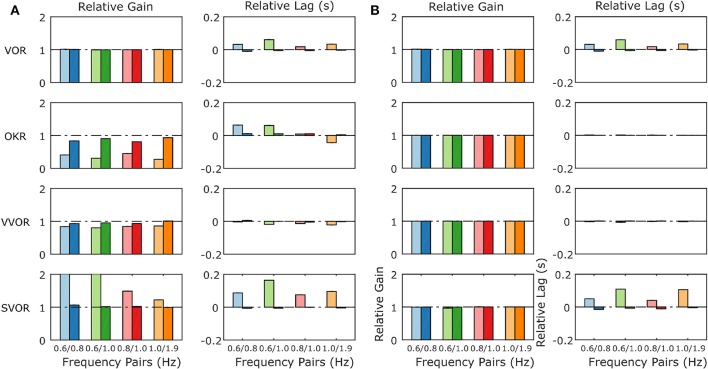
Summary of the model response to Sum of Sines stimulation for the model with normal retinal saturation (A) and with the saturation of retinal input removed (B). The response is described in terms of gains and lags relative to the gain and lag recorded in response to the single frequency component presented in isolation. A linear system will produce only relative gains of 1 and relative delays of 0, indicated by dashed horizontal lines on each plot. The pattern of non-linearities produced by the full model (A) matches closely the non-linearities found in behavioral data in response to the same stimuli (Sibindi et al., 2016). Figure 6 of Sibindi et al. (2016) is reproduced with consent as a supplement to this figure, Supplement Figure 1. The removal of retinal saturation eliminates the non-linearities expressed in the relative gains of the OKR and sVOR but those expressed in the relative lags of VOR and sVOR remain intact. Please note that the values for relative gain for the 0.6 Hz component of the 0.6/0.8 and 0.6/1.0 Hz Sum of Sines in sVOR (A) are >2.